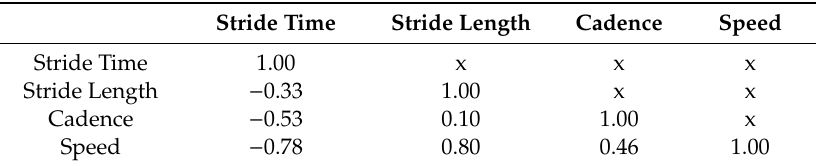
Table 7. Correlation matrix for the features of Set 1. Shown are the values for r.